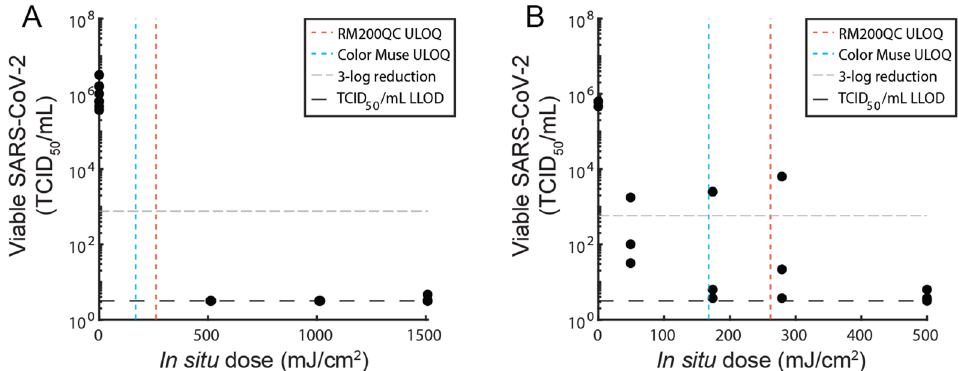
Figure 3. Dynamic range of SARS-CoV-2 dose response curve on N95 coupons is between 0 and 50 mJ/ cm 2 . SARS-CoV-2 recovery on 3M 1860 N95 coupons as a function of in-situ UV-C dose measured using a radiometer, for ( A ) doses between 0 and 1500 mJ/cm 2 , and ( B ) doses between 0 – 500 mJ/cm 2 . ULOQ = upper limit of quantification. LLOD = lower limit of detection. N = 3 replicates per